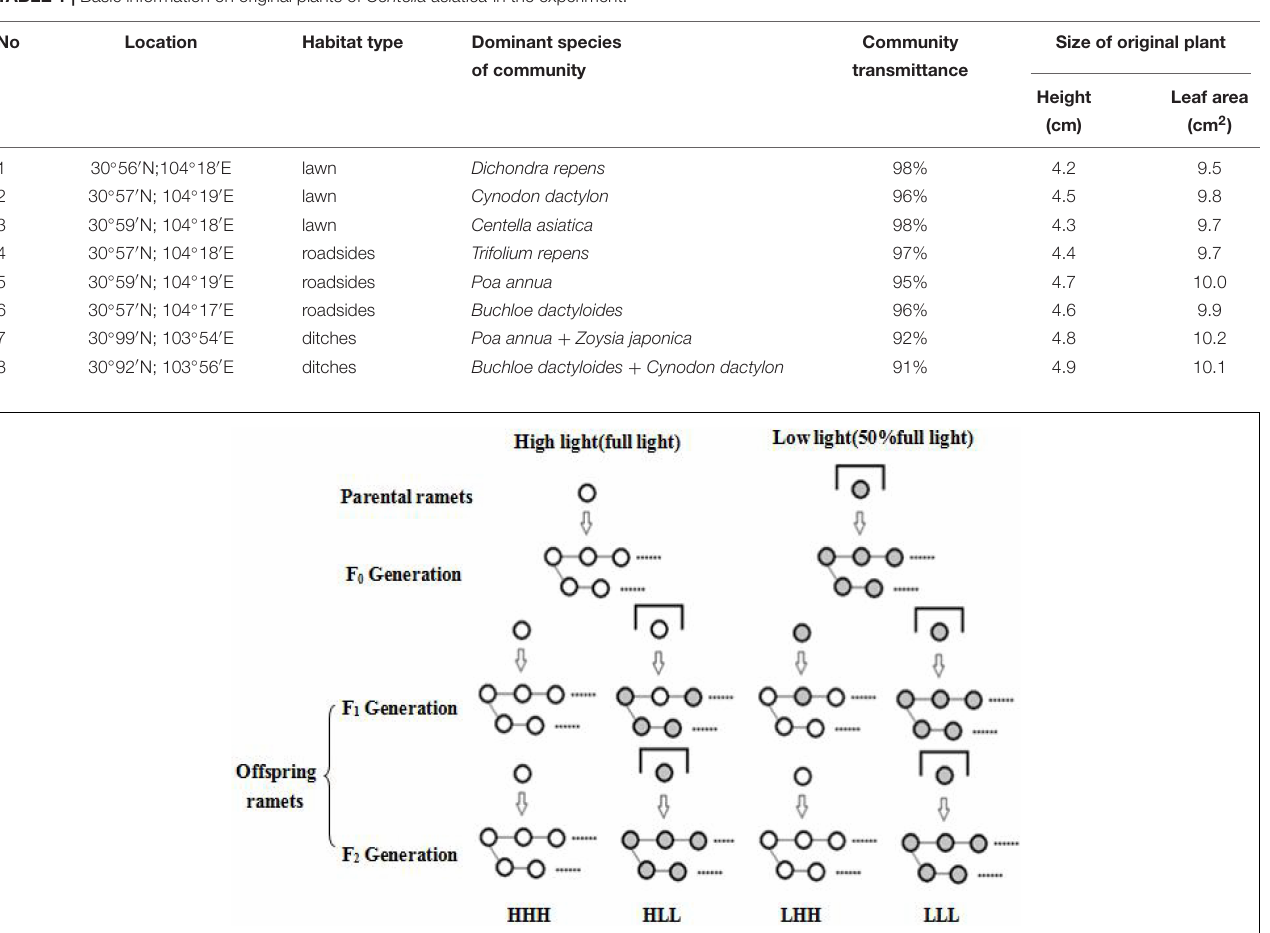
FIGURE 1 | Schematic diagram of the experimental design. The experiment is across three vegetative generations. Four treatments were included for F 2 generation: F 0 generation high light + F 1 generation high light + F 2 generation high light (HHH); F 0 generation high light + F 1 generation low light + F 2 generation low light (HLL);